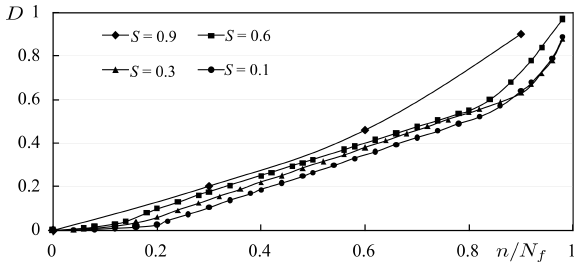
Figure 12. Curves of fatigue damage evolution of concrete